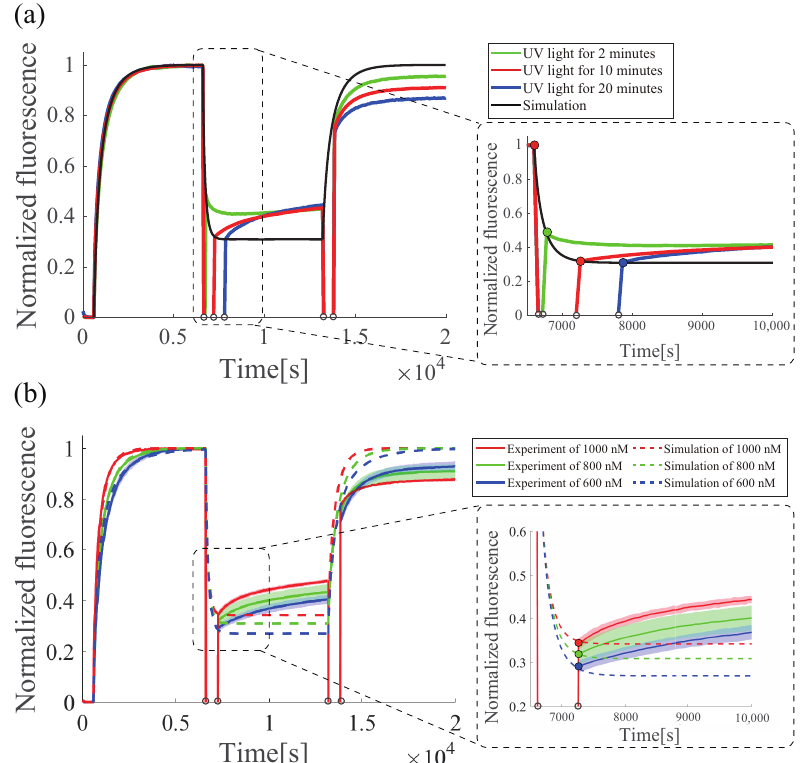
Figure 10. Parameter fitting of azo-degradation experiments and simulations. ( a ) Fitting at different UV irradiation times; and ( b ) fitting at different gate concentrations. Different gate concentrations were averaged over three times, and the UV irradiation time experiments were conducted once. Colored areas represent the standard